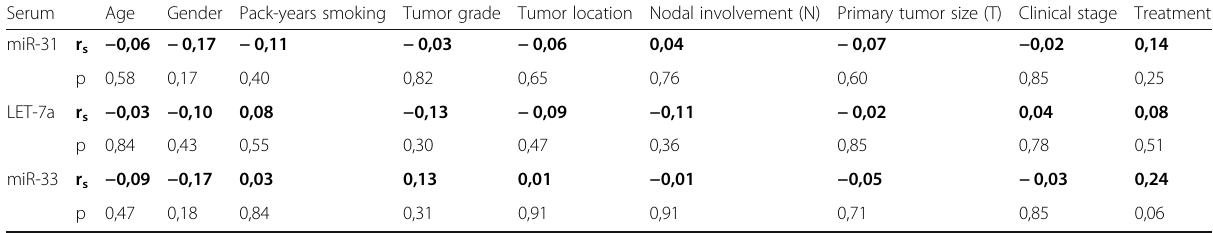
The Spearman ’ s rank correlation coefficient (r) and (p) is